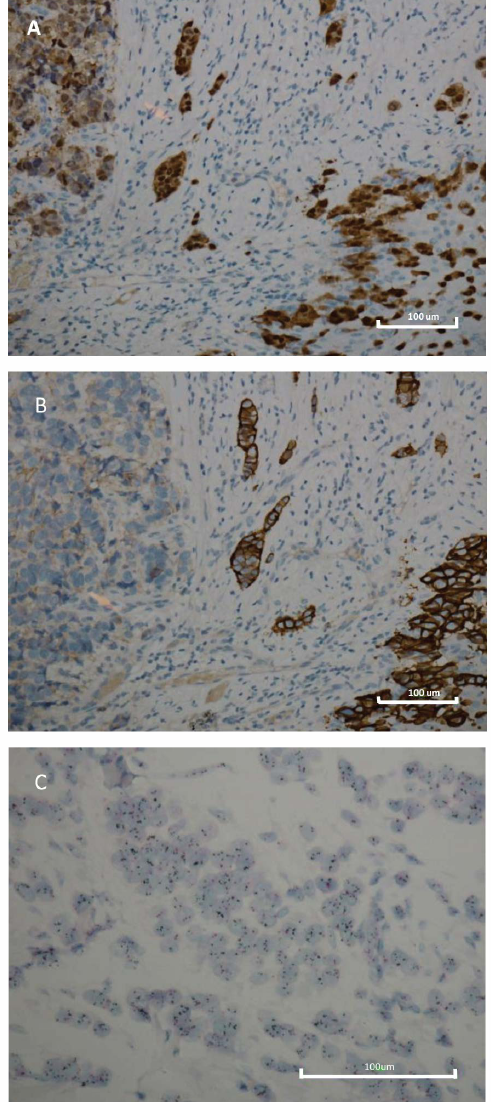
Figure 1. Immunohistochemistry and silver in situ hybridization features of breast cancer. ( A ) Immunohistochemistry for AR displaying diffuse and intense nuclear immunoreactivity (original magnification 200 × ); ( B ) Immunohistochemistry for HER2 displaying diffuse and intense membra- nous immunoreactivity (original magnification 200 × ); ( C ) Determination of HER2 gene status using the Dual SISH kit (Ventana) of a breast carcinoma with HER2 gene amplification; HER2 (black) and Chr17 (red). Scale bar: 100 µ